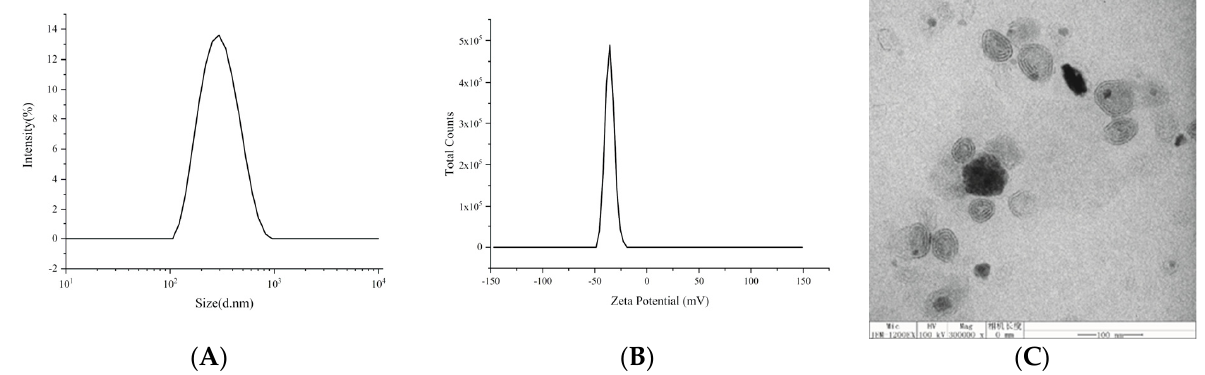
Figure 7. Characterization of heparin lipid microemulsion (HEP-LM): ( A ) particle size distribution; ( B ) zeta potential; ( C ) TEM images (scale bar represents 100 nm). Table 2. Physicochemical characterization of HEP-LM (mean ± SD, n = 3). PDI, polydispersity in- dex; EE%, encapsulation efficiency.